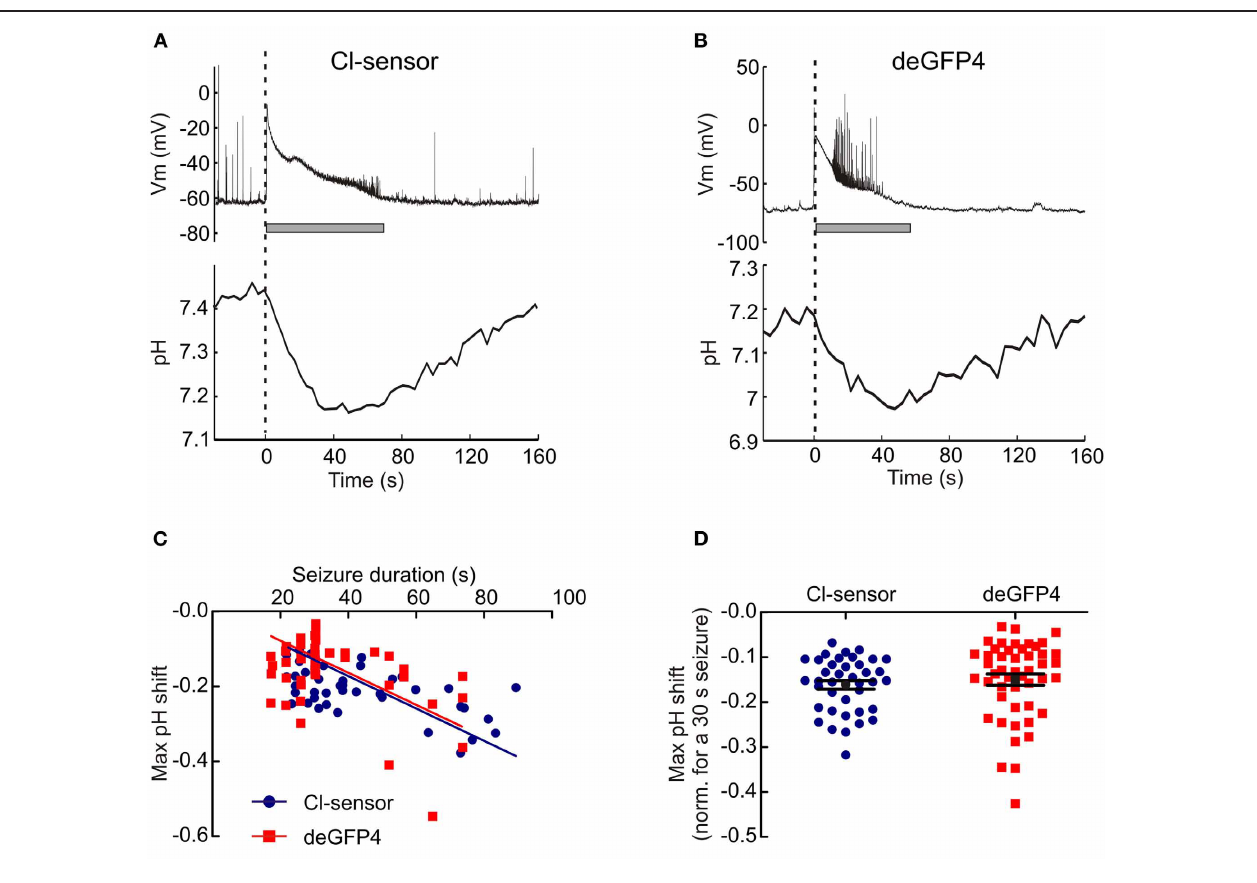
FIGURE 4 | 0Cl − induced epileptiform activity induces acidic transients in neurons. (A) The intracellular pH of a hippocampal CA1 pyramidal neuron transfected with Cl − sensor recorded during an episode of 0Cl − induced epileptiform activity. Similar to the 0Mg 2 + model, the seizure onset (dashed line) is correlated with the start of a decrease in intracellular pH. The pH continues to decrease during the seizure, reaches a minimum around the time of seizure termination, and then recovers to baseline during the post-seizure period. (B) Similar acidic transients